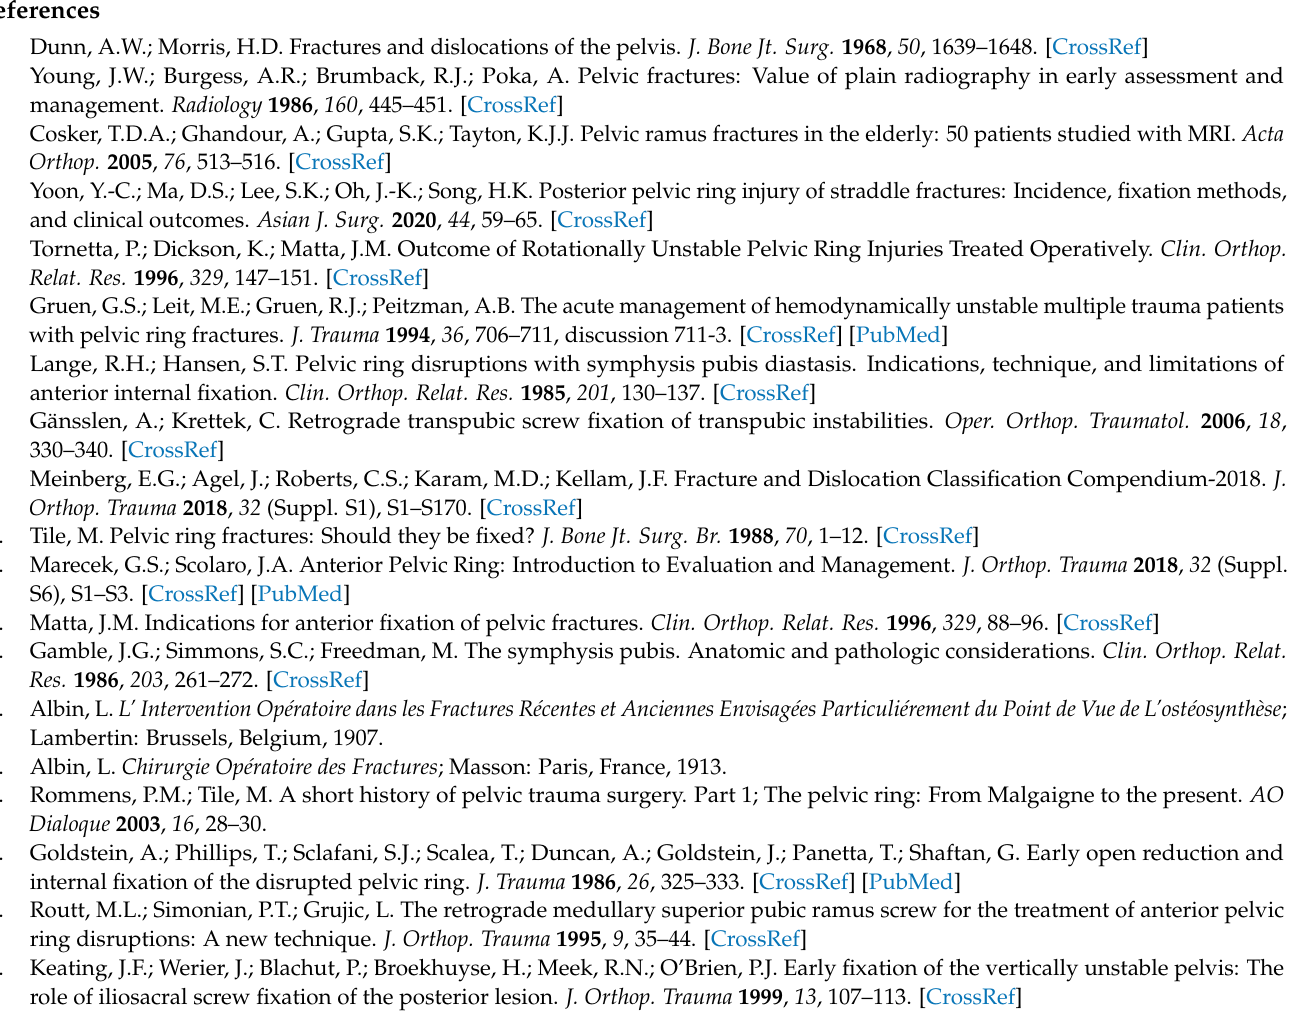
Figure A2. Predrilling of the retrograde transpubic screws was performed with a 3.5 mm drill bit. An aiming template made of polymethylmetharcylate was used to achieve the best possible instrumentation